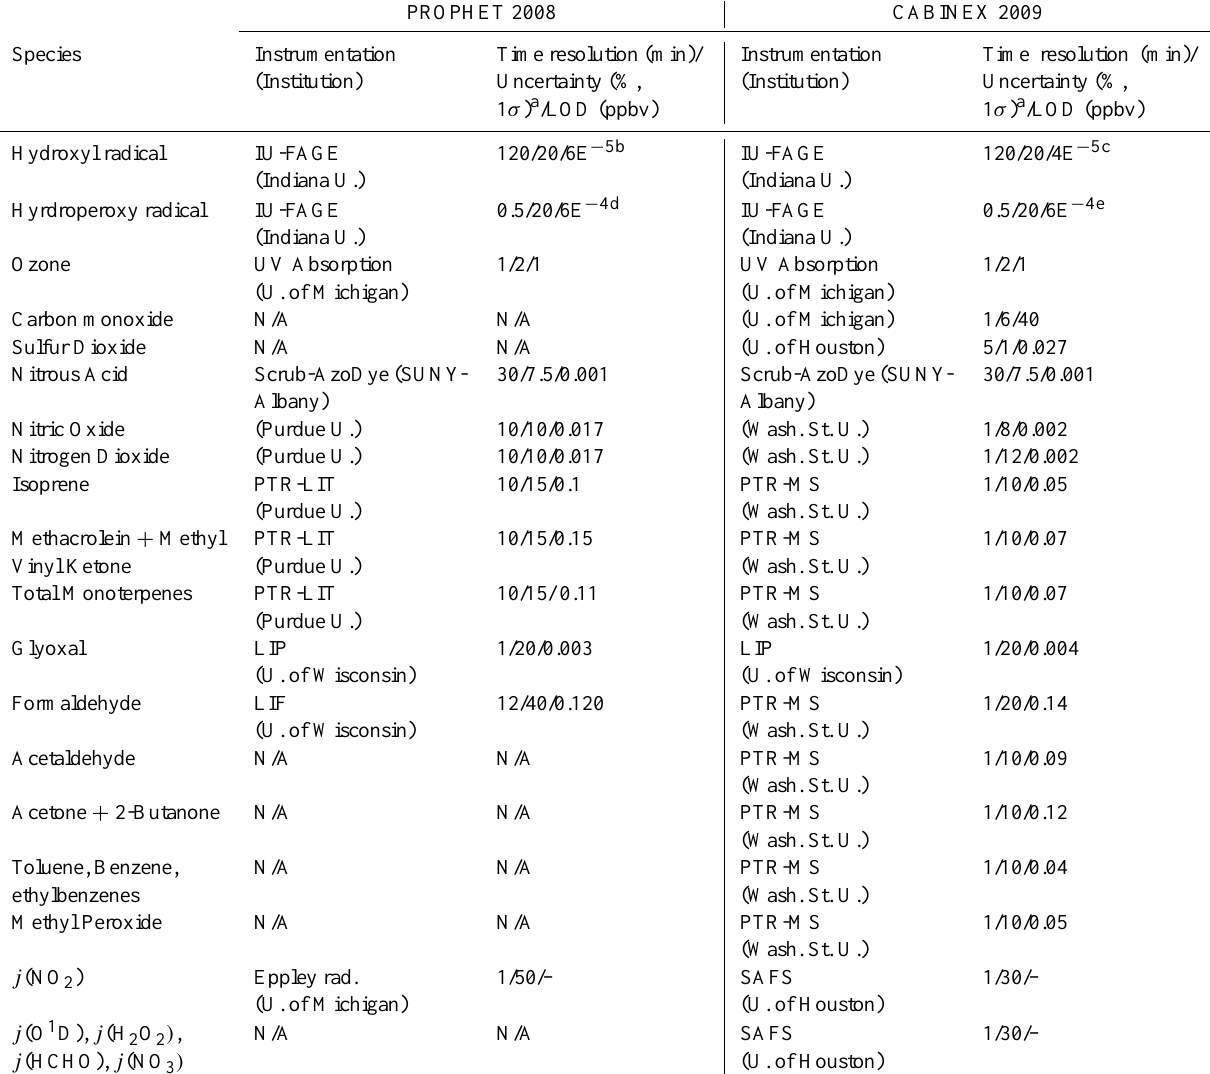
Table 2. Instrumentation used to measure above canopy